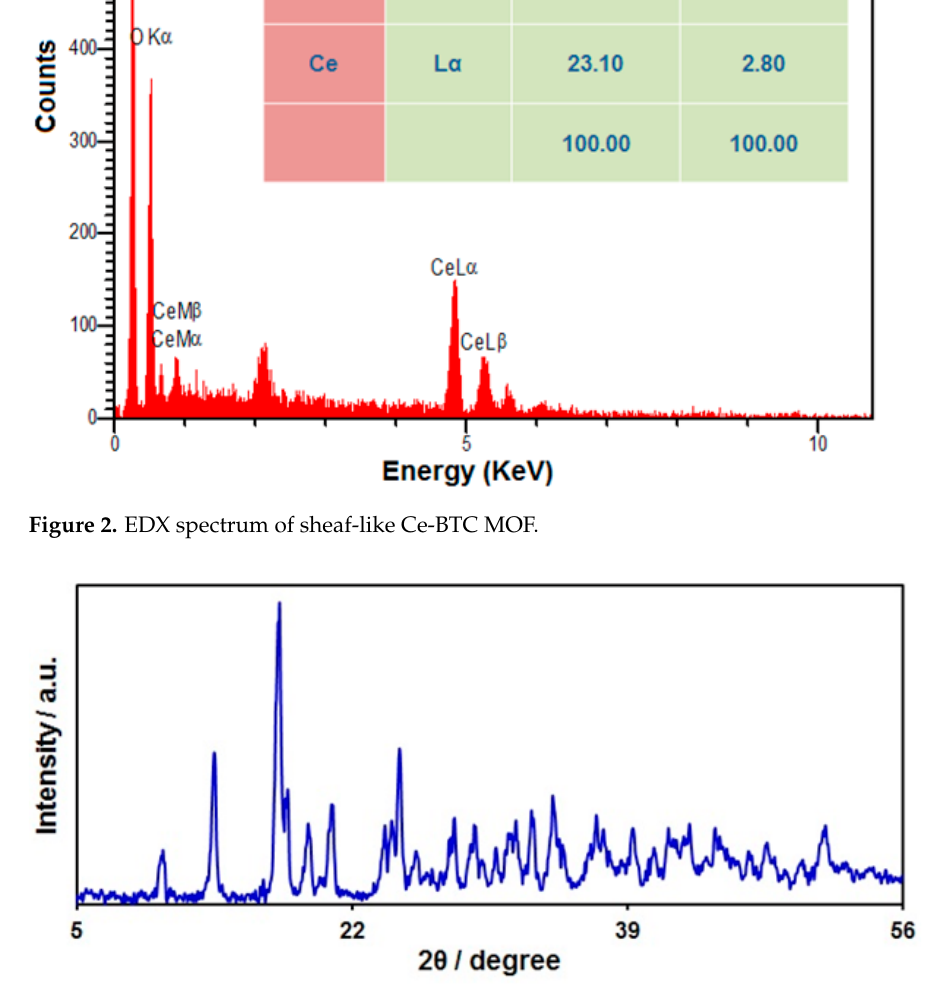
Figure 3. XRD pattern of sheaf-like Ce-BTC MOF.